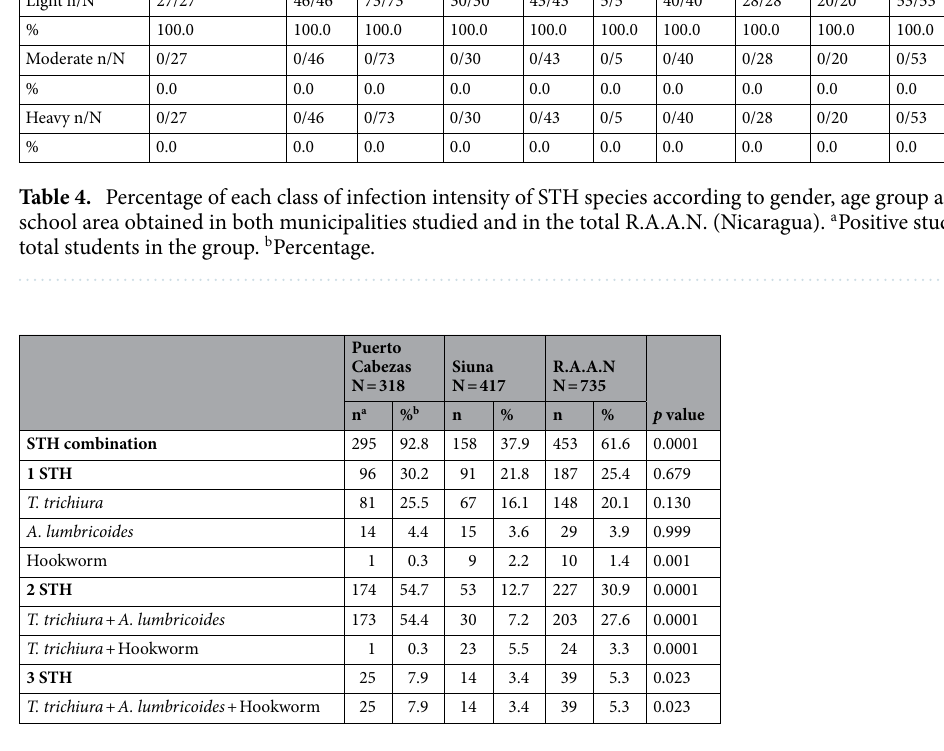
Table 5. Frequency of STH infection grouping obtained in the two municipalities studied and in the total R.A.A.N. (Nicaragua). a Positive students in the group. b Percentage.